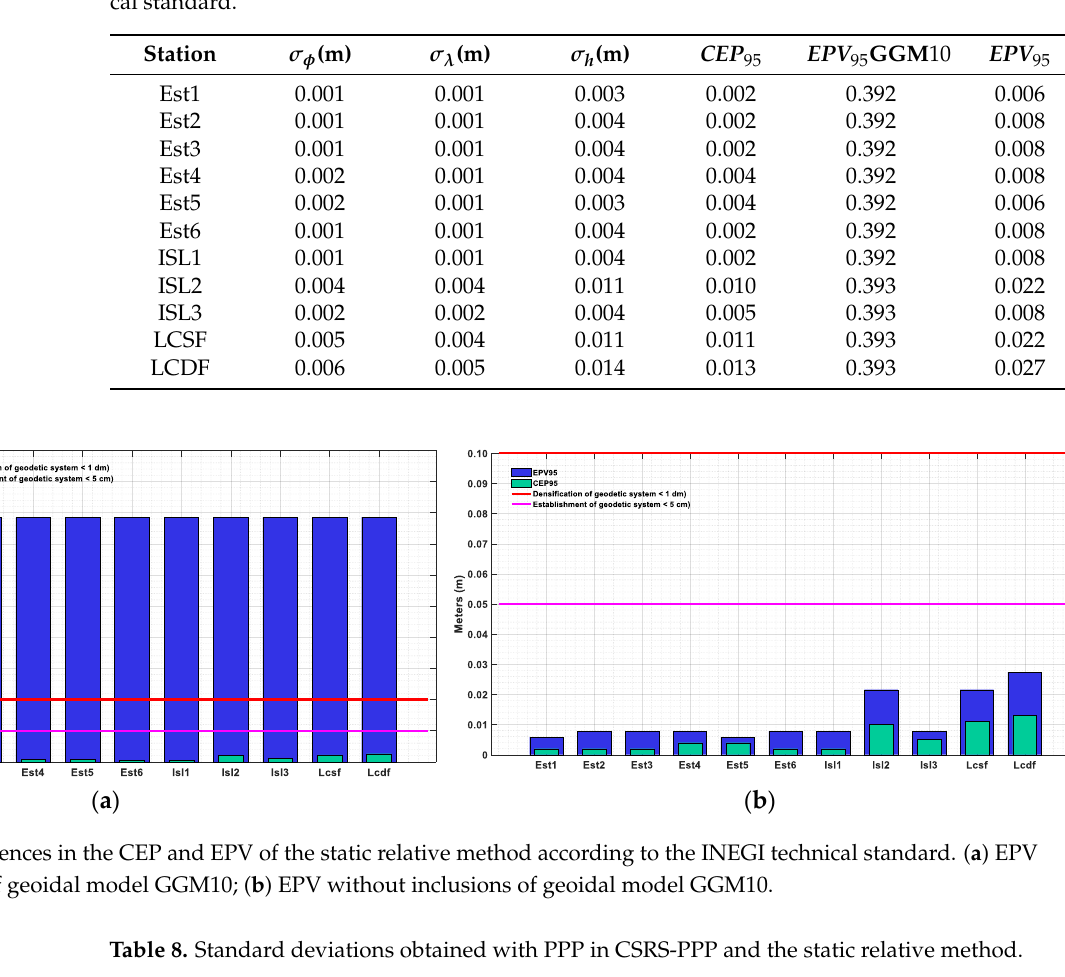
Table 7. Results of the CEP and EPV of the static relative method according to the INEGI technical standard. Station